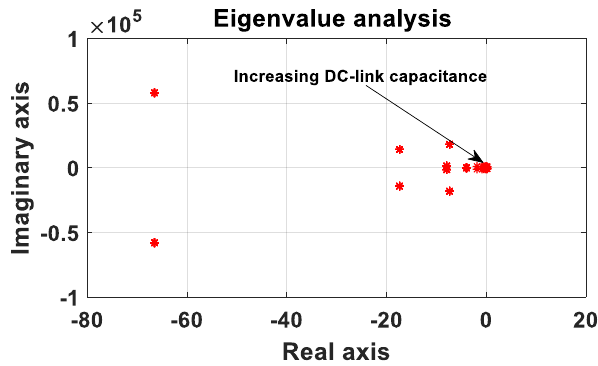
Figure 7. Impact of the DC-link capacitance on the DC grid.